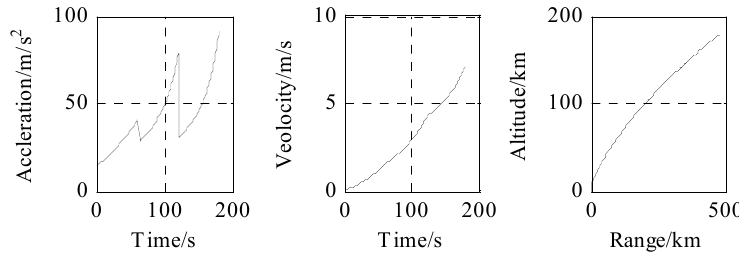
Figure 5. Motion modeling of boost Figure 5 . Motion modeling of boost phase.